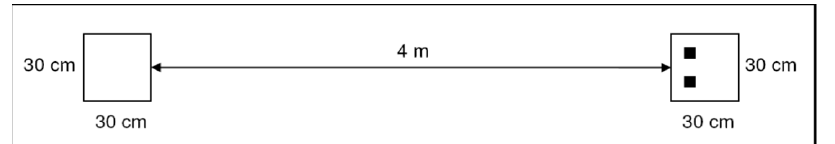
Figure 2. Test setup ‘Shuttle Run’, ©Testmanual KiMo-Test; Dr. rer. nat. S. Dordel, Dr. sports scient. B. Koch, Dipl.-sports scient. D. Klein; Institute of Movement and Neurosciences German Sport (2) ‘Standing long jump’ (SLJ) (Figure 3): This test examined the explosive power in the children’s lower extremities. The children were asked to jump with both legs as far as possible from a starting line before landing on both legs without falling over. The distance was measured in centimetres, the better of two attempts was recorded for the